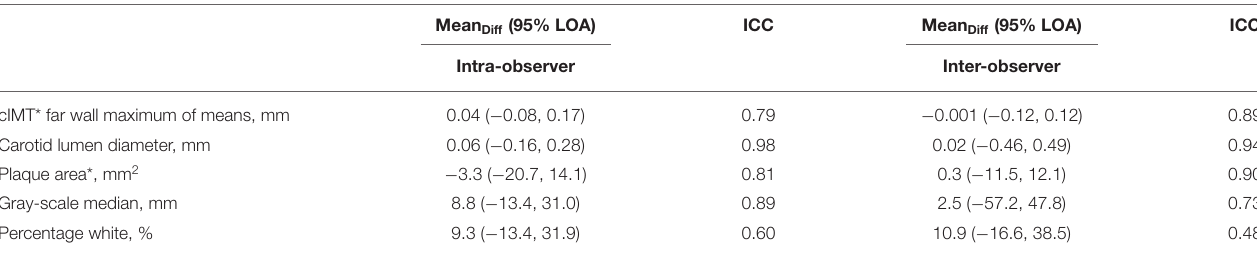
TABLE 7 | Reproducibility of carotid intima medial thickness (cIMT)